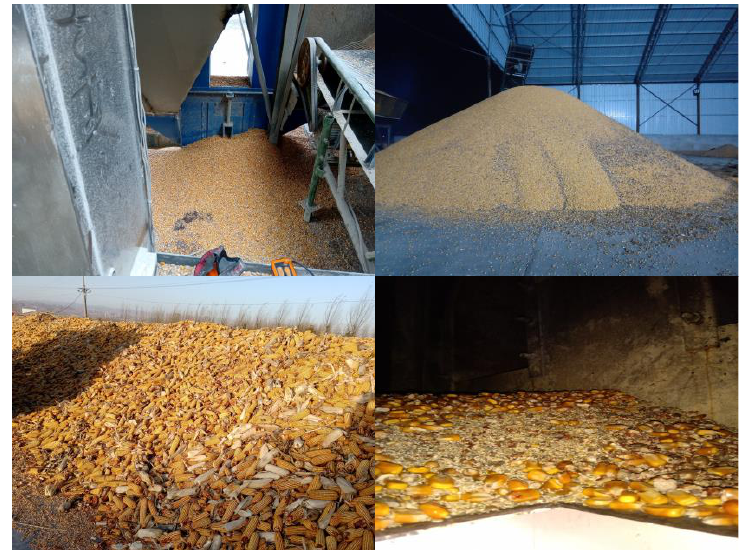
Figure 3. Main impurities mixed with corn to be dried.